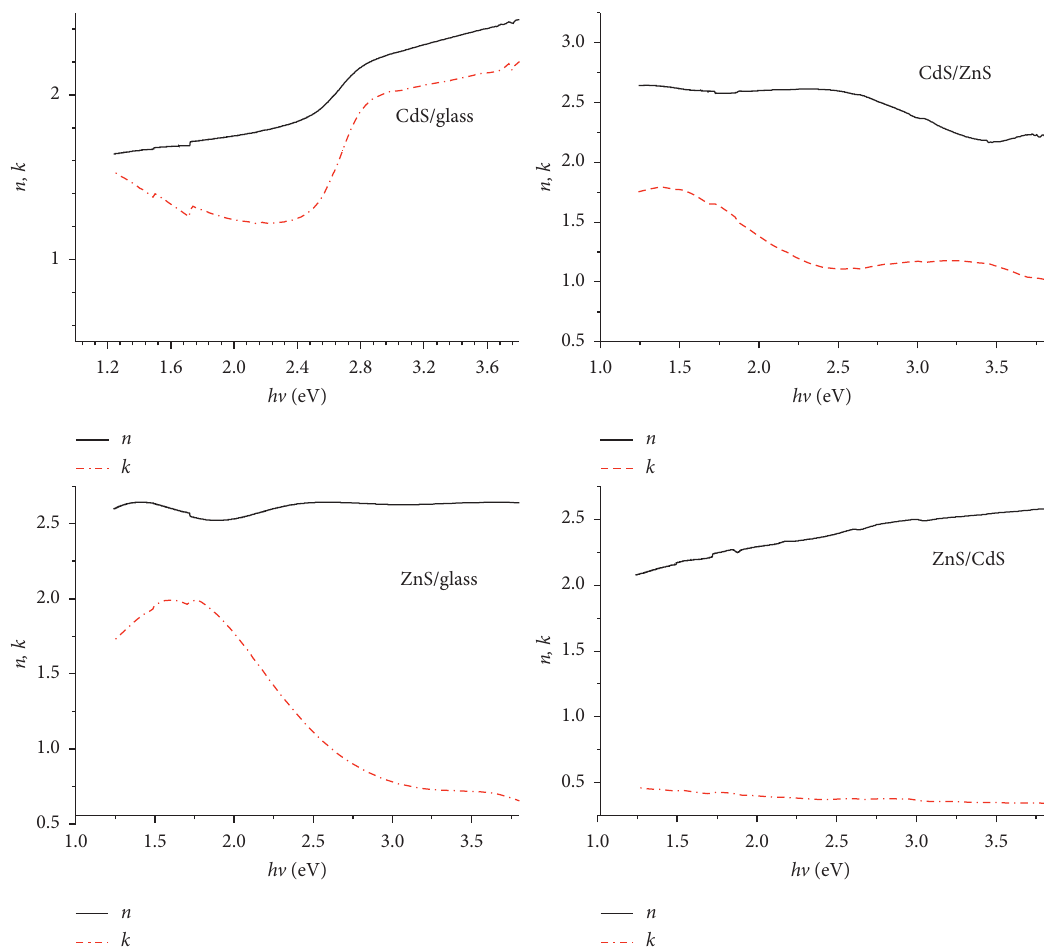
Figure 3: Refractive index n and extinction coefficient k of CdS/glass, CdS/ZnS, ZnS/glass, and ZnS/CdS thin